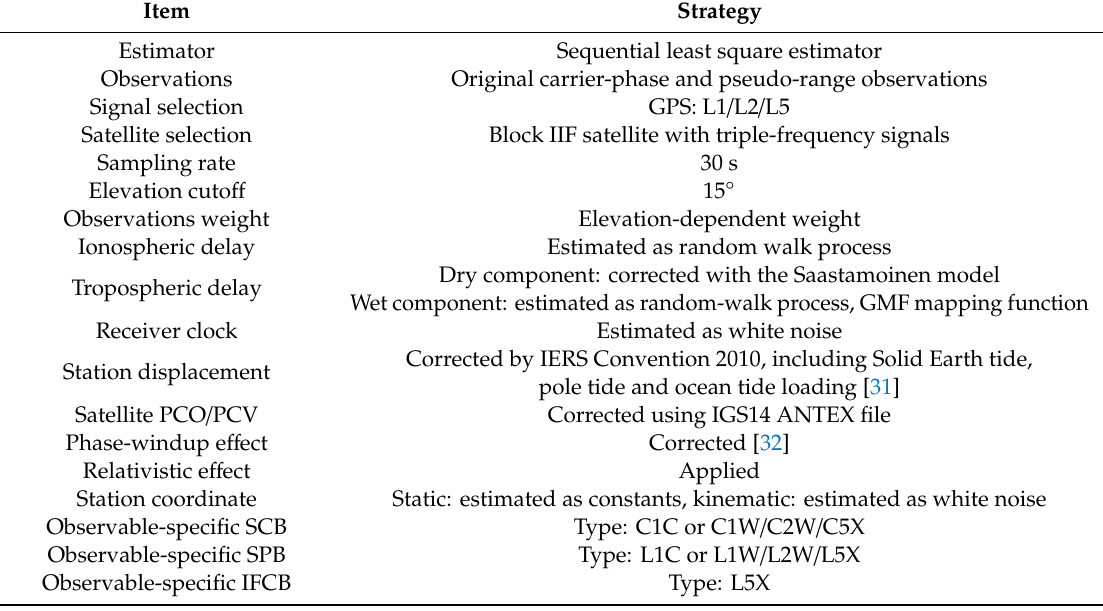
Table 3. GPS un-di ff erenced and uncombined precise point positioning ambiguity resolution (UDUC-PPP AR) processing